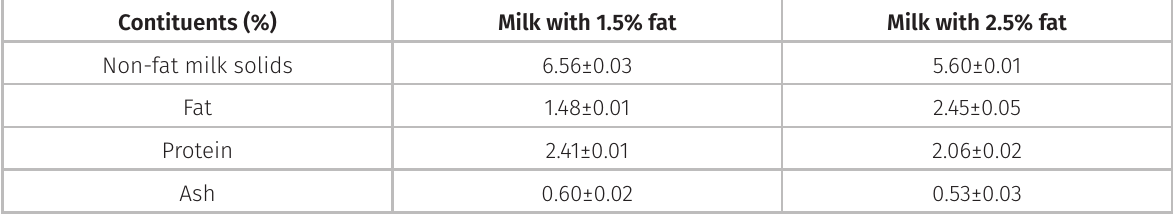
Values are the means ± standard error (n =